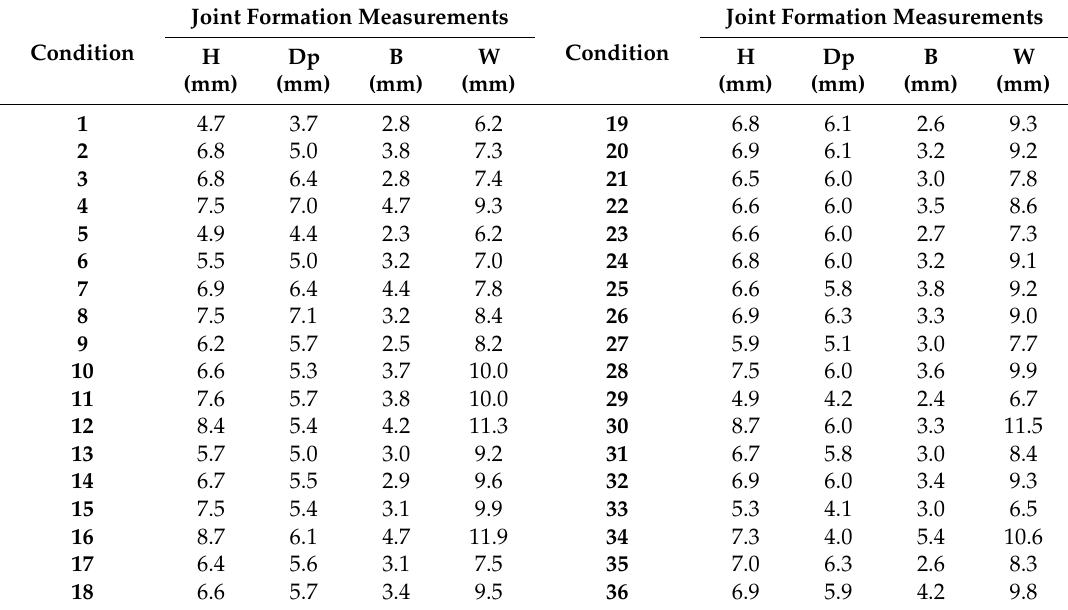
Table 3. Geometry variations in the plastically deformed rivet tip.